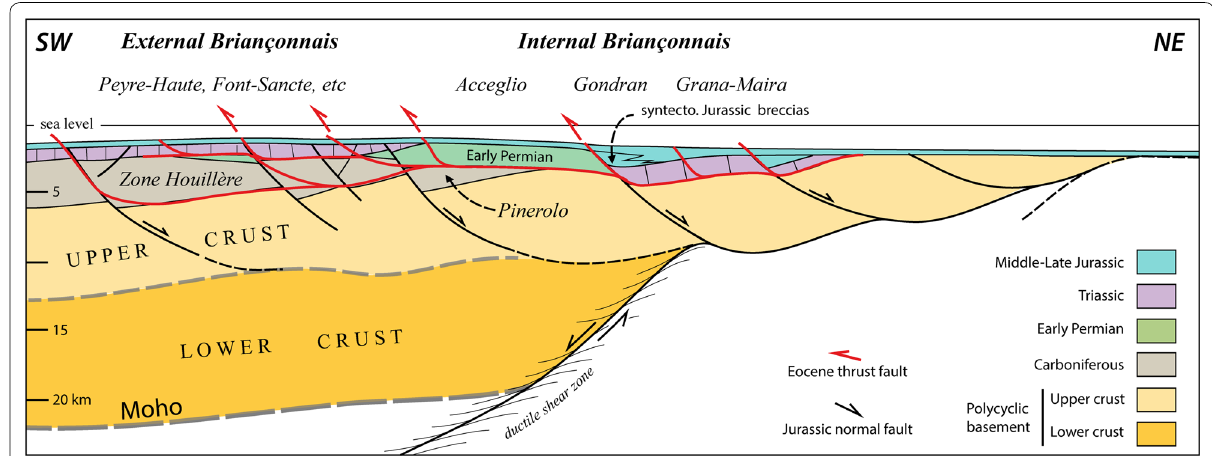
Fig. 12 Proposed correlations between detached cover nappes (External and Internal Briançonnais) and subducted basement slices (Dora-Maira Massif). See text for further